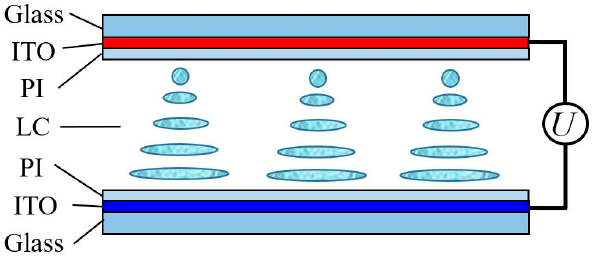
Figure 1. Schematic of LC cell capacitance model.